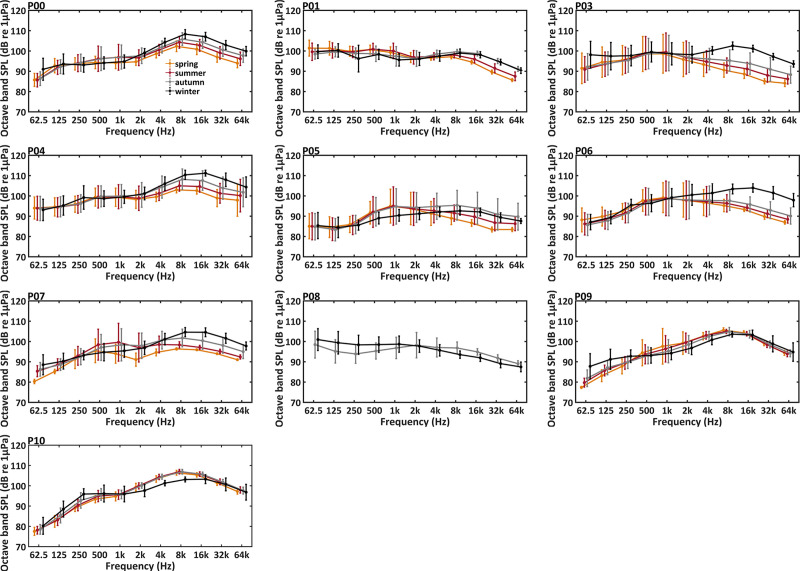
Seasonal trends of octave band sound pressure levels (octave band SPLs) at the PAM sites.Differences among spring (March, April and May), summer (June, July, and August), autumn (September, October and November) and winter (December, January, and February) are marked with *** for p-level < 0.001; ** for p-level < 0.005; * for p-level < 0.05 (Kruskal-Wallis test).